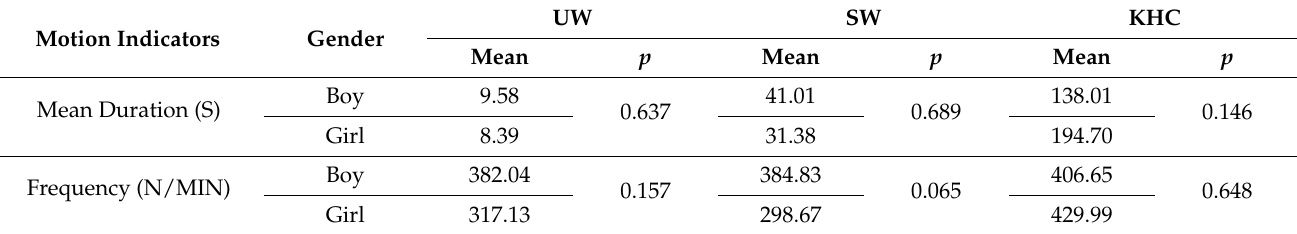
Table 4. Relationship between gender with motion-capture measures.